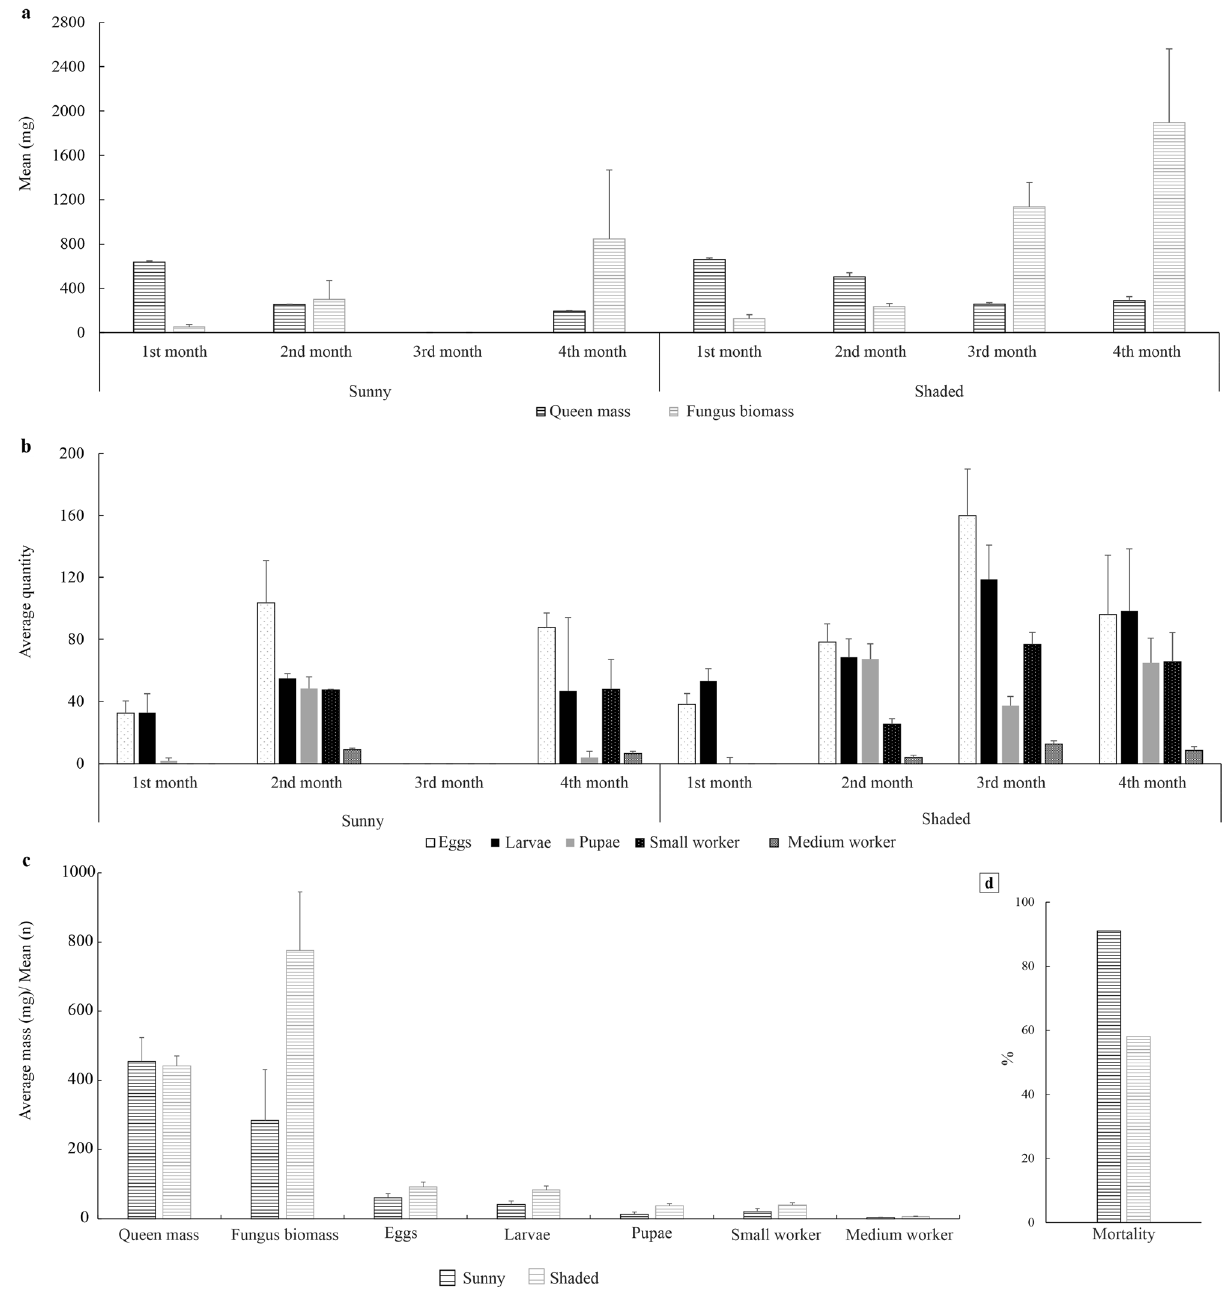
Figure 2. Development of Atta sexdens (Hymenoptera: Formicidae) nests in a sunny and shaded environments over 4 months ( a , b ) and 4-month average of biology ( c ) and mortality ( d